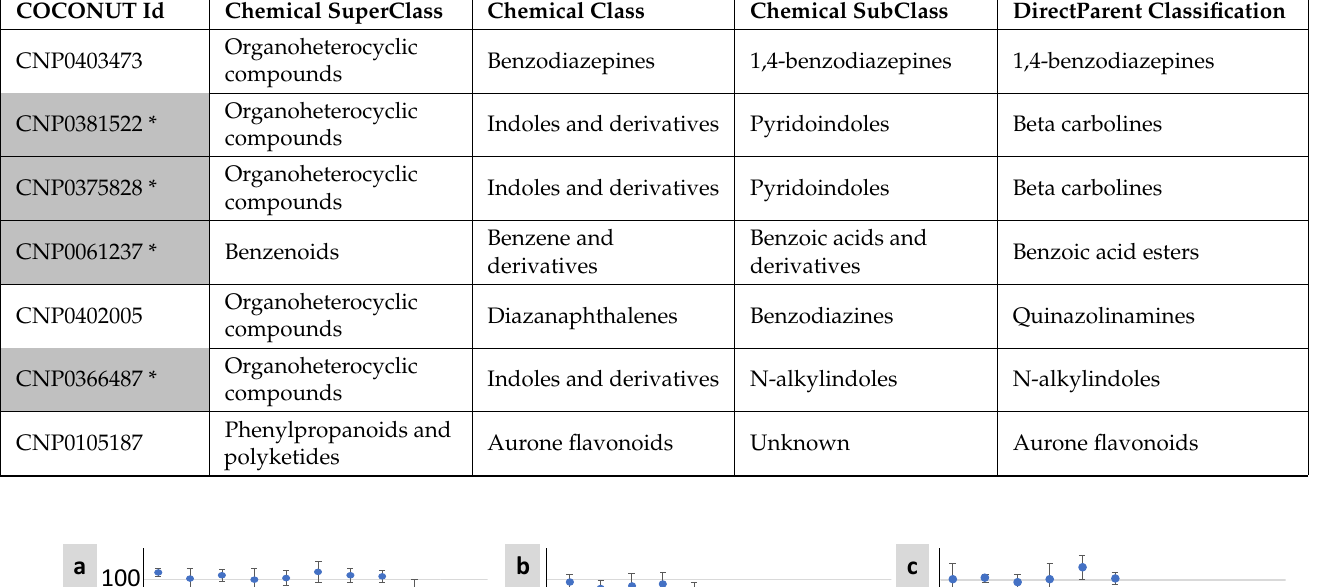
Table 4. Classification of the seven NPs used for in vitro M pro inhibition assay. COCONUT Ids in bold, gray color and with asterisk show in vitro inhibition.